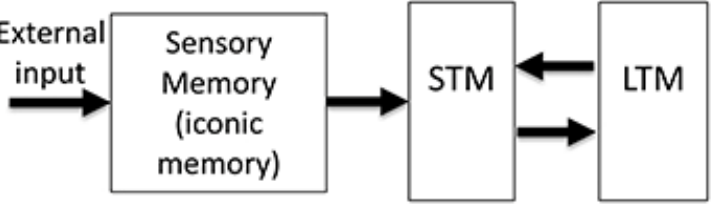
Figure 1. Atkinson Shiffrin model. It is a multi-store model consisting of Sensory Memory (SM), Short-Term Memory (STM), and Long-Term Memory (LTM). Each store has distinct properties. From Ref. [3].